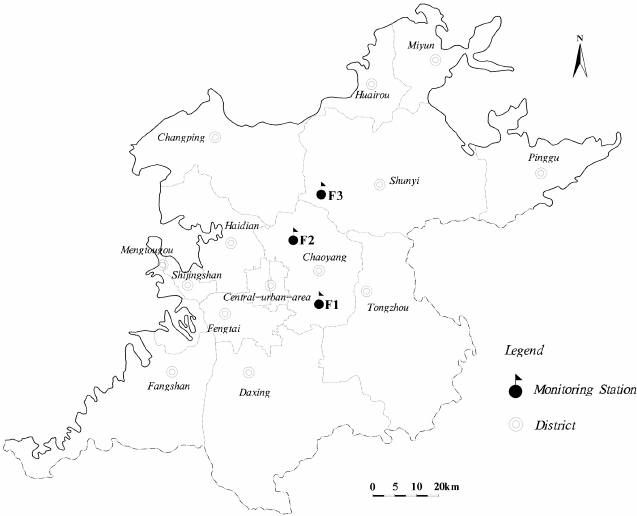
Figure 1. Location of three monitoring stations (F1, F2 and F3) for land subsidence in Beijing.